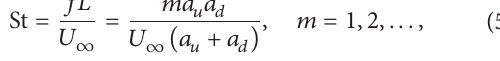
(longitudinal oscillation) and (4) (transverse oscillation) are listed in Table 3. The spectral peaks in Figure 4 are assigned not only to a longitudinal oscillation (St 2 , St 4 , St 5 , and St 7 ) but also to a transverse oscillation (St 1 and St 3 ). This finding implies that the flow for 𝐿/𝐷 = 1.8 oscillates not only longitudinally but also transversely. The weak peak, St 6 (=1.27), might appear as a result of the amplitude modulation because St 6 is expressed by St 7 − St 1